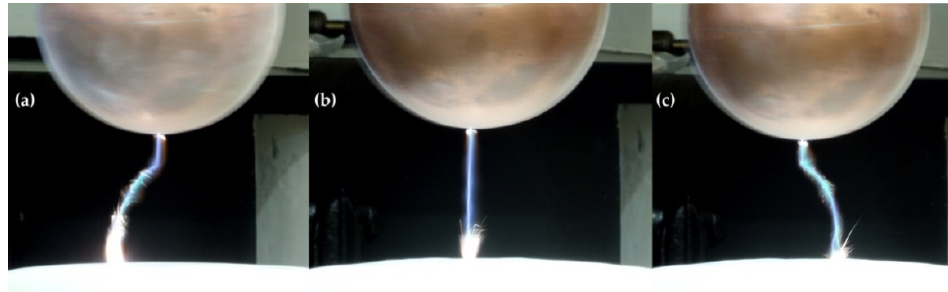
Figure 5. Various types of lightning strikes incepted for the loose talc surface on latex (8 s exposures). Most of them appeared along the central axis of the system (which is consistent with other experiments [23]), but not all of them; the formation of the discharge channel was affected by the talc particles moving in the electric field. Particles superheated and expulsed in the air can be seen near the talc surface and in the ( a , c ) discharge channels; channel ( b ) remains clear. It can be noticed that the upper electrode becomes covered with the intercepted talc particles; image ( a ) has been lighted differently during the exposure, apparently showing a different amount of talc powder accumulated on the electrode (in reality, it was constant in all three images).